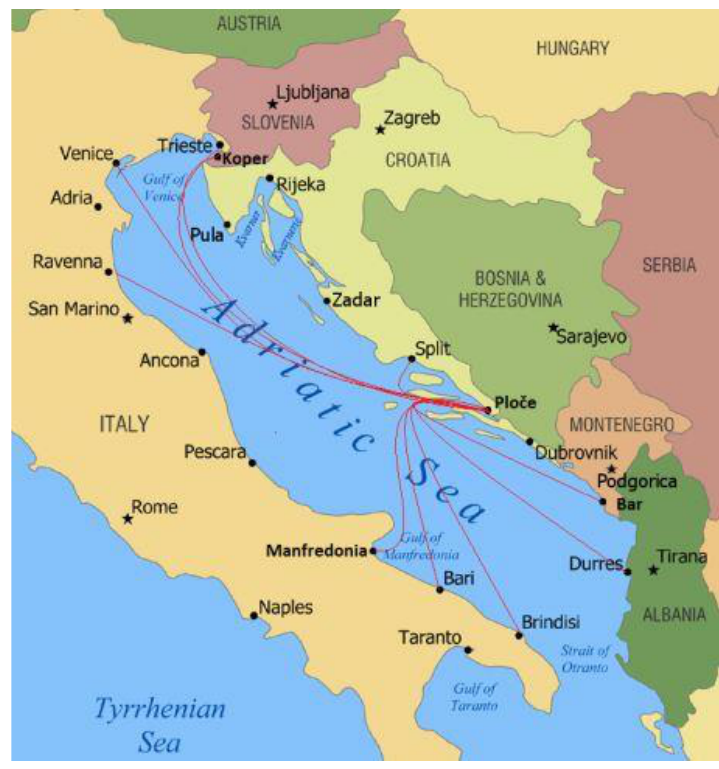
Figure 4. Main Adriatic Sea routes calling the Port of Ploče. Source: adopted from [57]. The percentage of BW discharged by a ship flag is presented in Figure A7 (ten ship flags that discharged the largest quantities of BW). As seen, Malta and Panama flagged ships discha rged 40% of BW in the Port of Ploče, followed by Liberia (8%) and Italy (5%). Moreover, the authors analysed BW quantities discharged by ship flags according to the number of ship calls (Figure A8). Most frequent visitors were again Malta and Panama flagged ships (150 arrivals), followed by Turkey (53) and Albania (35) flagged ships. Furthermore, according to Paris MoU White, Grey and Black List flags, the authors divided BW discharging ships into four groups. The other group was ships ’ flags which were not listed in either of the groups. As presented in Figure A9, White list flagged ships discharged 83% of BW (864,253.2 m 3 ) in the Port of Ploče. The background of dividing BW discharging ships according to the Paris MoU Flag List performance is that the ships ’ flags on the Black and Grey list are considered to have poorer performance than ships on the White List; therefore, it might be considered that such ships will have some deficiencies regarding BWM. However, from Figures A9 and A10, it might be concluded that the vast majority of discharged ballast came from White list flagged ships. Only in the years 2018 and 2020, were there more than 15,000 m 3 of BW discharged from Black list flagged ships; however, Paris MoU Black List flagged ships in the surveyed period discharged a total of 9% (91,732.1 m 3 ) of BW. Furthermore, when recorded BWM deficiencies found by Paris MoU inspectors were compared between Paris MoU Black and Grey list flagged ships and Panama and Malta flagged ships (flags that discharged most of the BW and most frequent visitors to the Port of Ploče), it was found that more defi- ciencies were recorded on Panama and Malta flagged ships. Data refer to all Paris MoU inspections from January 2019 to June 2022 (not only Croatia).